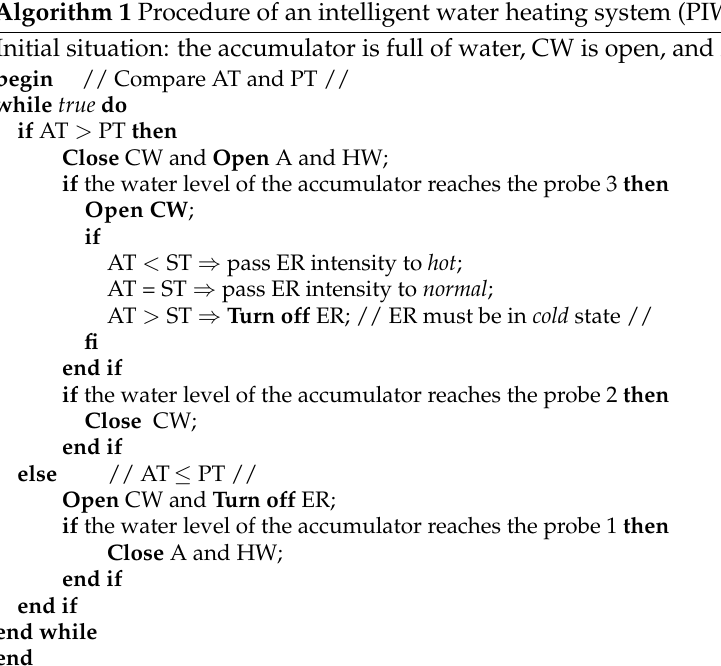
Algorithm 1 Procedure of an intelligent water heating system